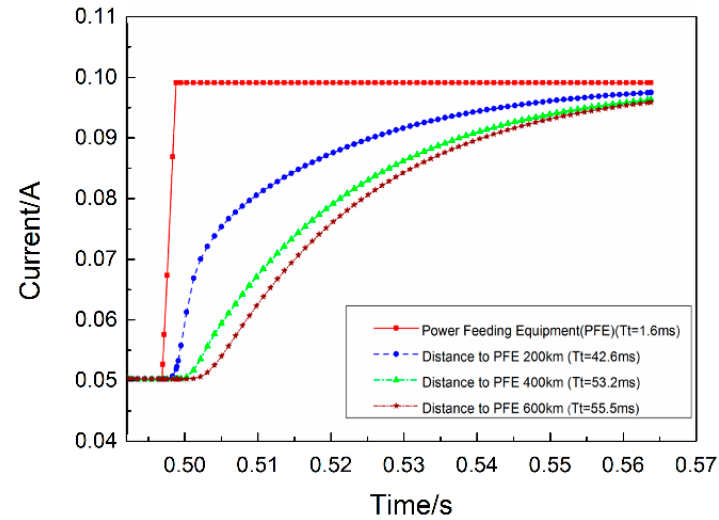
ff erent positions of a 600 km